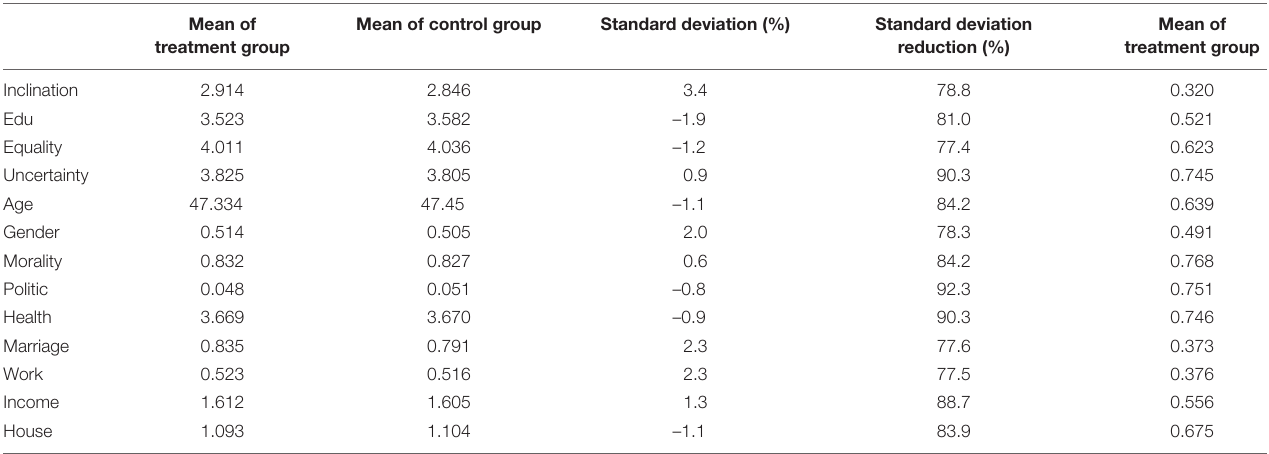
TABLE 7 | Results of balance test.